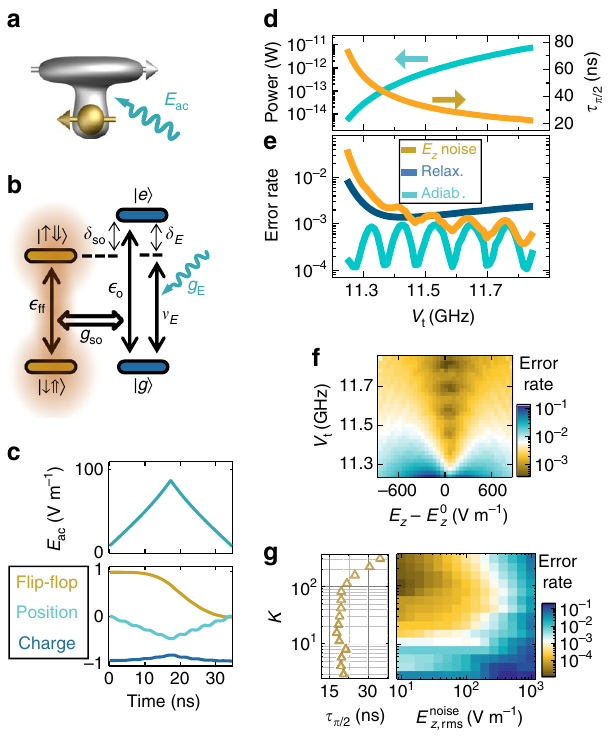
Fig. 4 High- fi delity electrically driven adiabatic x ( y )-gates. a Spatial representation and b level diagram, for electrical drive of a fl ip- fl op qubit, showing partially ionized electron wavefunction and spin arrows. c Time- dependent adiabatic drive amplitude and qubit dynamics of a π /2 x -gate, ; and V = 11.5 GHz. Bottom plot shows fl ip- for K = 30, B 0 = 0.4 T, E z ¼ E 0 (cid:13) (cid:12) t z fl op z state, σ ff , electron position, 〈 σ z 〉 , and charge qubit state, z e j i e h j (cid:3) g j i g h jh i . For the same parameters, d shows the averaged drive power and gate time, and e the error rates for different V t . To estimate the drive power, we assumed a 50 Ω line in which a 1 μ V AC voltage produces a 10 V m − 1 AC vertical electric fi eld. f Estimated fl ip- fl op qubit π /2 x -gate ¼ 100 V m − 1 . g error due to quasi-static noise with amplitude E noise z ; rms